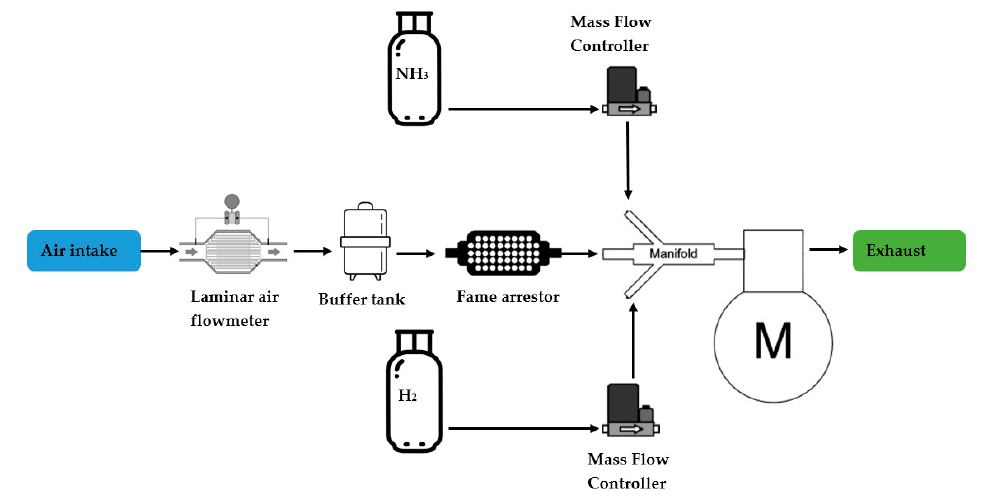
Figure 9. Diagram showing the fuel system setup for the experiments